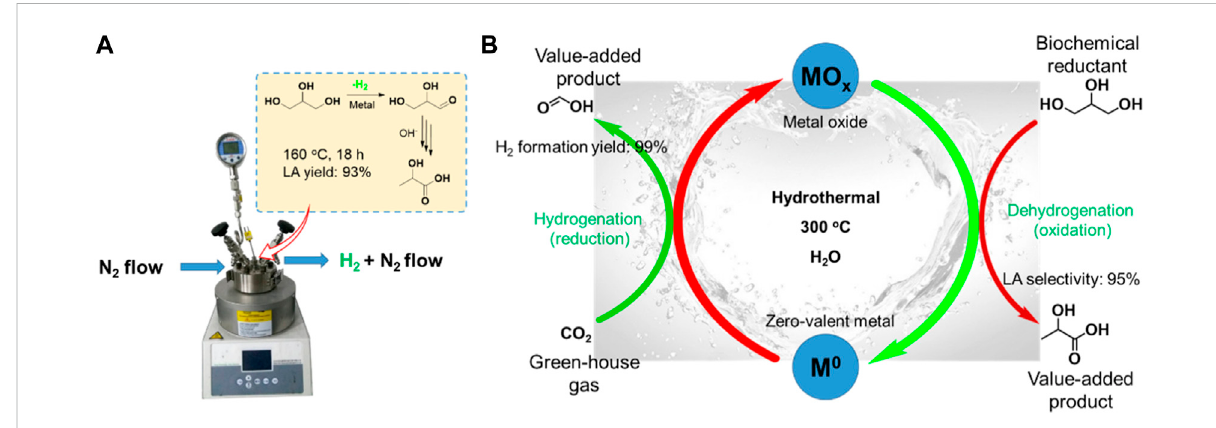
FIGURE 5 (A) Conversion of glycerol to LA under N 2 fl ow. (B) Carbon cycles with biochemical as reductants via M 0 /MO x redox cycles (Jin et al.,